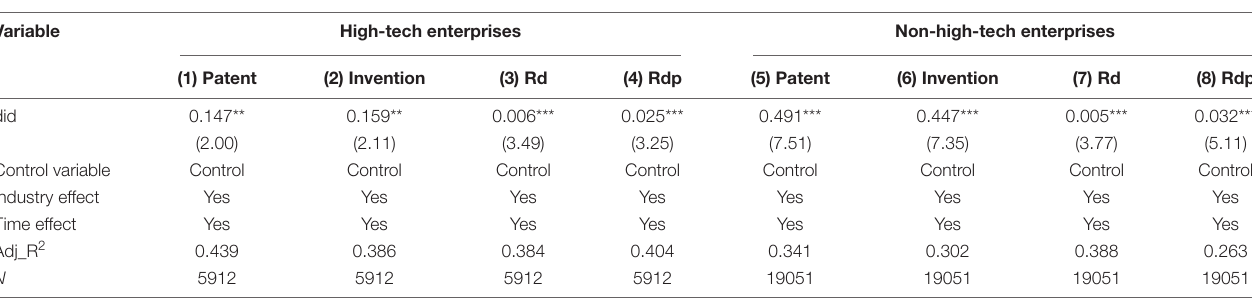
TABLE 9 | Heterogeneous regression results of high-tech